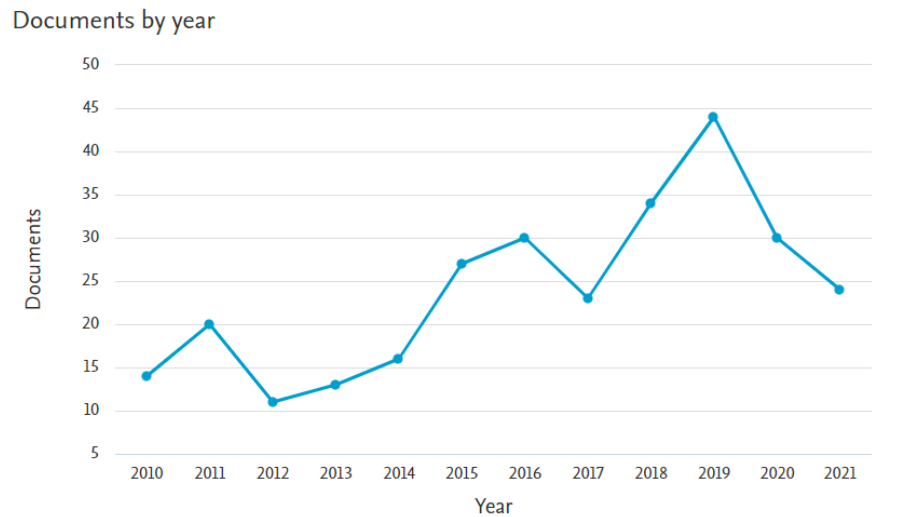
Figure 3. Histogram of question answering semantic search engine publications from 2010 to 2021.